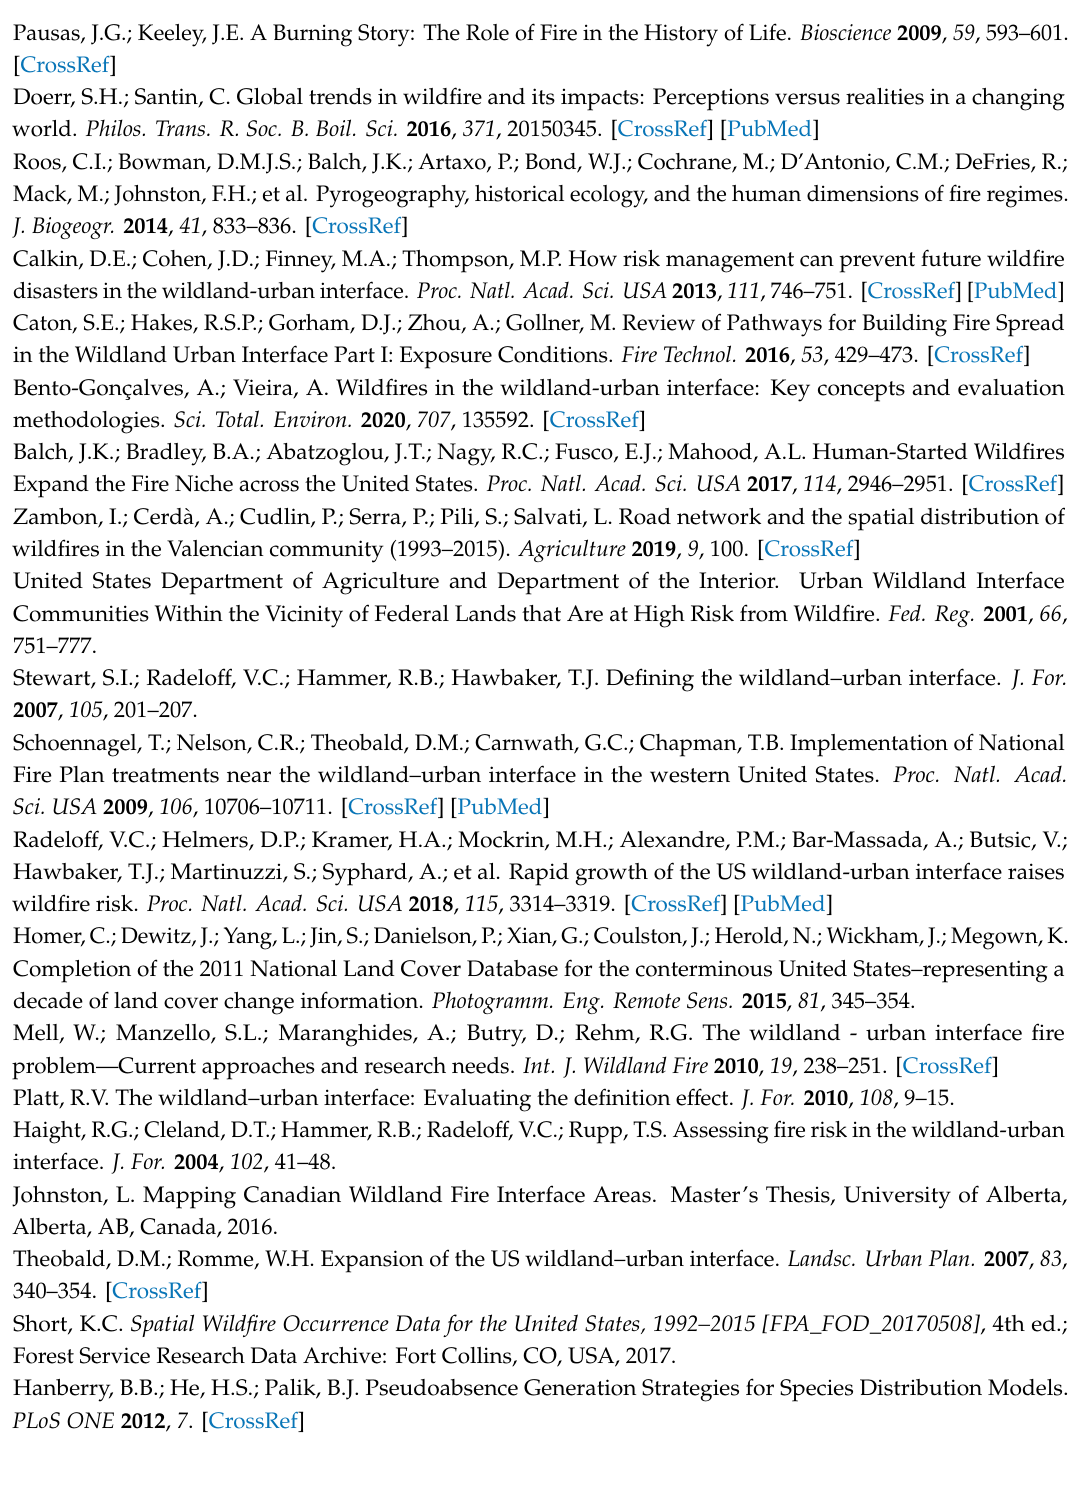
Figure S1: Classification trees or rules for the conterminous United States, Figure S2: Classification trees or rules by region, and Figure S3: Classification trees or rules for interface and